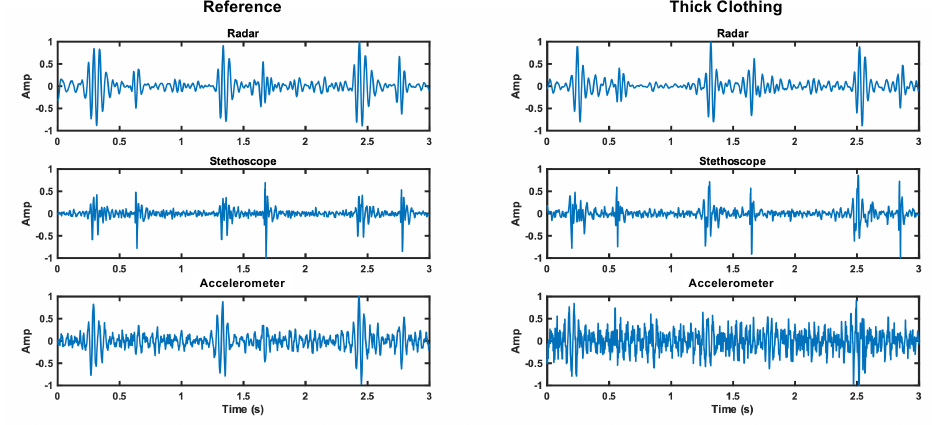
Figure 15. Comparison of the time domain waveforms for each measurement method under reference and thick clothing cases. The noise floor increase is apparent for the